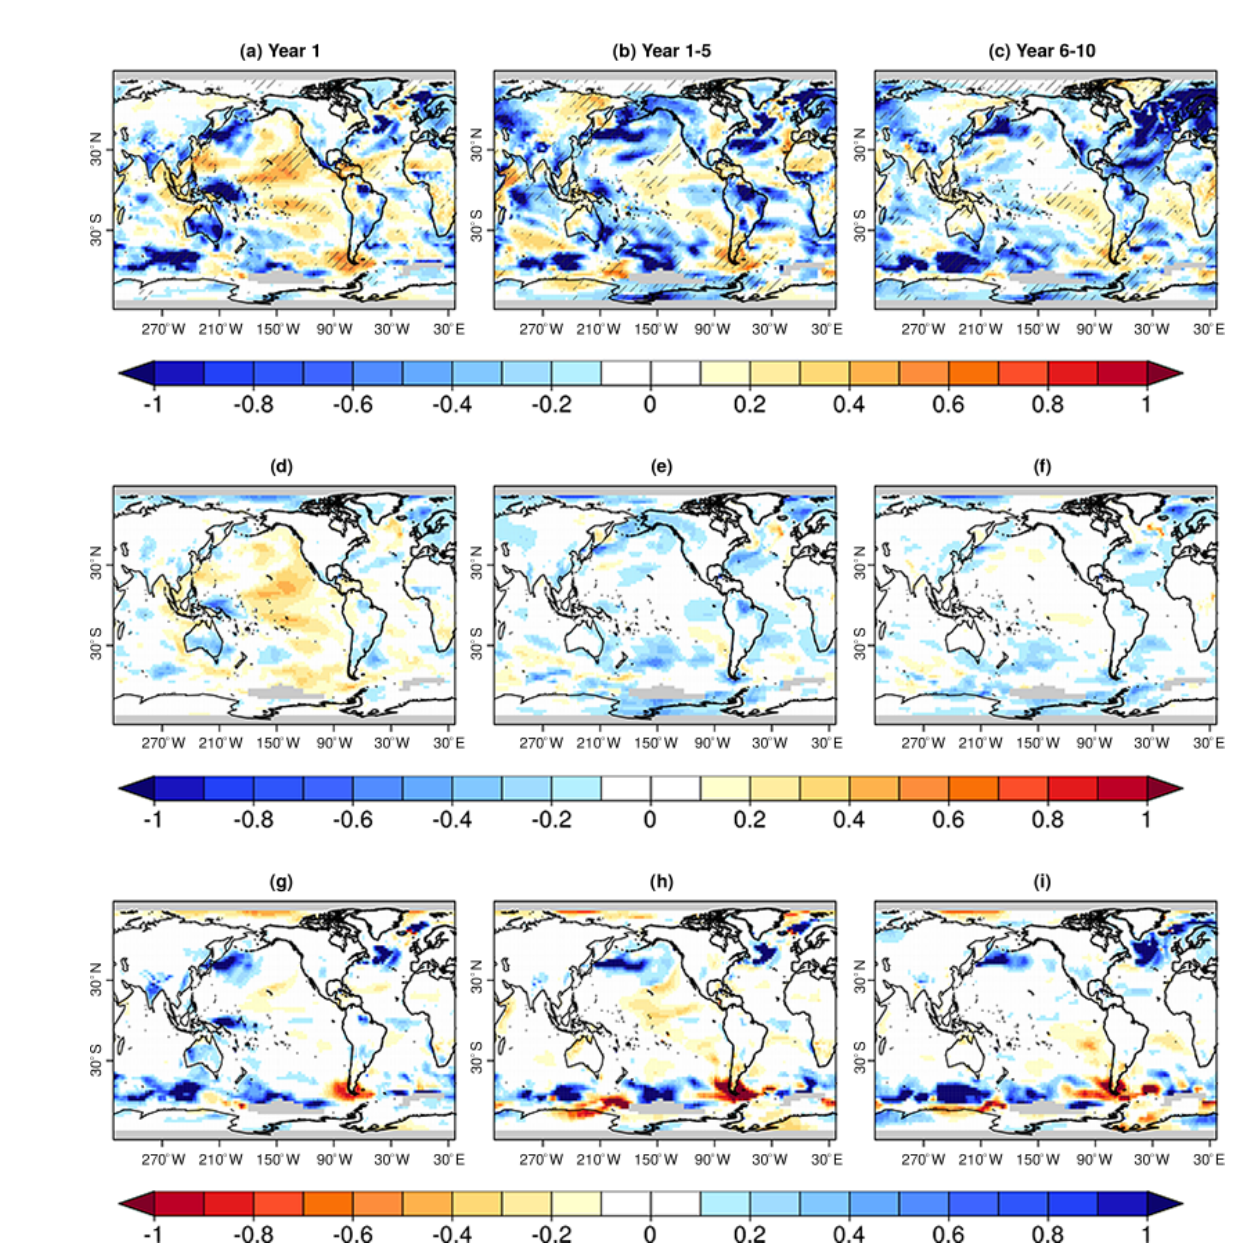
Figure 3. Mean square skill score (MSSS) of the annual mean surface temperature (SAT and SST blend) in PRED using HIST as the reference forecast (see Sect. 2.3) for forecast years (a) 1, (b) 1–5 and (c) 6–10. Hatching indicates where the MSSS is significant using a random walk test (see Sect. 2.3). Its sign is determined by the difference between the terms in panels (d–f) and (g–i) (see Eq. 2). Panels (d–f) show the difference between the squared ACC values in PRED and HIST for the same forecast years. Panels (g–i) show the difference between the squared conditional biases in PRED and HIST for the same forecast years. Note that the colour scale in panels (g–i) is reversed with respect to the other rows so that positive values contribute to improved skill from initialization. GISTEMPv4 is used as the observational reference for all calculations. Annual mean anomalies are computed by masking PRED and HIST with the GISTEMPv4 missing values (masked in grey) and using the common 1970–2018 climatology